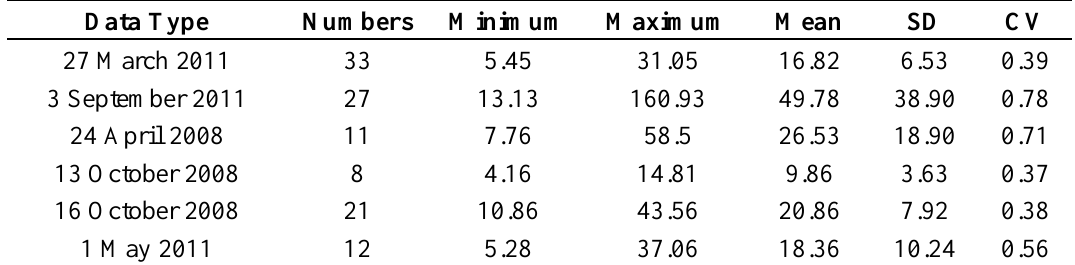
Table 1. Chla (μg∙L −1 ) in Lake Taihu (SD: standard deviation; CV: coefficient of variation in percent ( i.e. , SD/mean of parameter)).